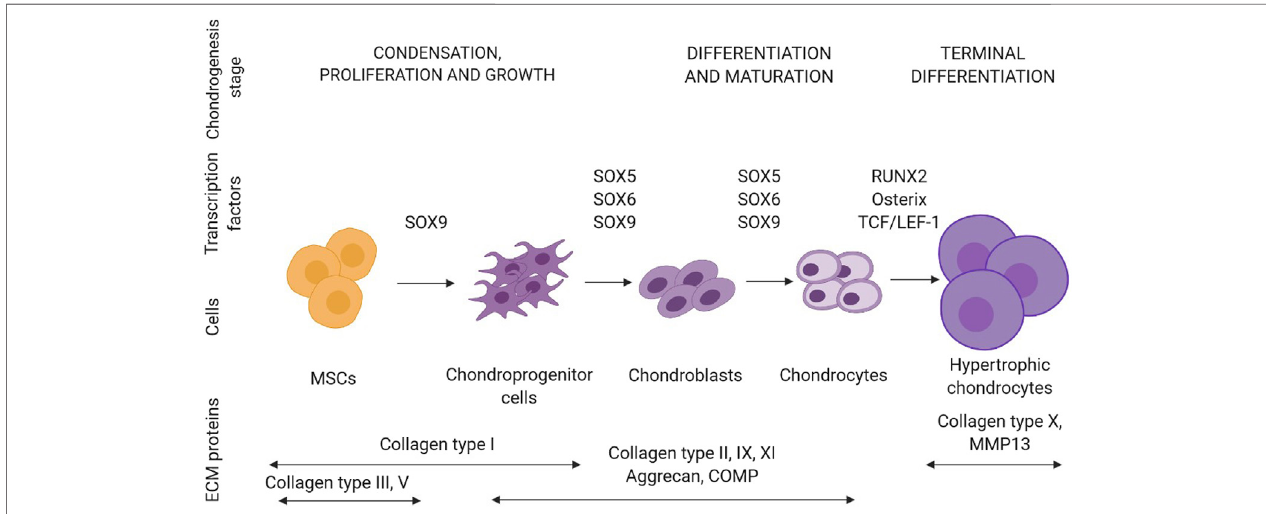
FIGURE 3 | Schematic representation of a sequence of events leading to the differentiation of mesenchymal stem cells (MSCs) towards chondrocytes (created in BioRender.com). In each stage of chondrogenesis, the temporal expression pro fi les of ECM proteins and transcription factors are highlighted. Abbreviations: COMP, cartilage oligomeric